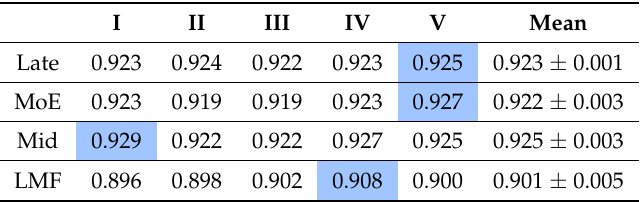
Table 4. The comparison of four fusion methods performed on the PHAC-2 dataset. All values represent the Area Under a Curve (AUC)-Receiver Operating Characteristic (ROC) performance